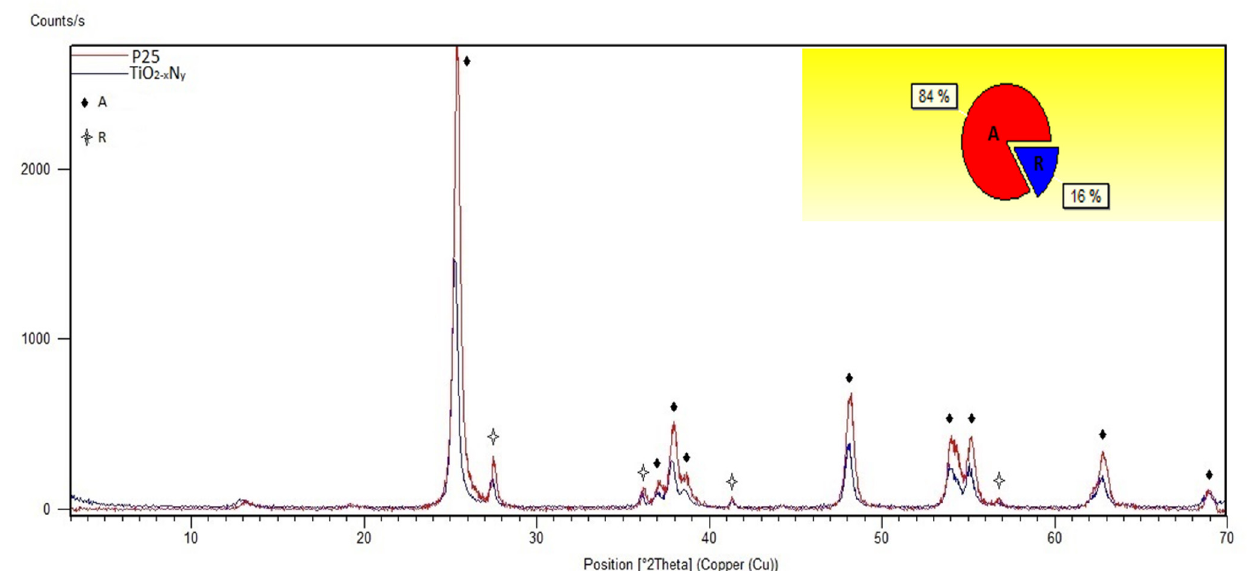
Figure 1. X-ray diffractogram (XRD) of Aeroxide P25 (TiO 2 ) vs. TiO 2 − x N y ; phases anatase (A) and rutile (R).